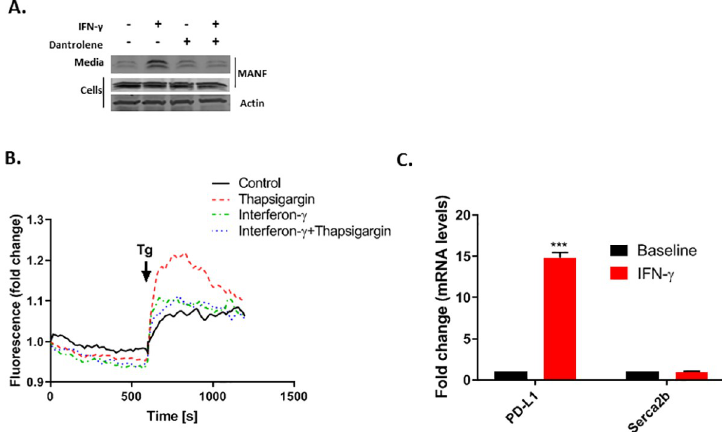
Fig 4. MANF release in response to IFN- γ treatment is mediated by ER Ca 2+ depletion. ( A ) SKMEL28 cells were treated with 100 ng/ml IFN- γ and/or 30 μ M Dantrolene as indicated for 48 hours, followed by immunoblot analysis of the cells and media. Data are representative of three independent experiments. ( B ) SKMEL28 cells were treated for 48 hours with IFN- γ or control as indicated prior to loading with Fluo-3-AM. Thereafter, the medium was switched to 1mM EGTA in HBS and supplemented after 10 min with 1 μ M Tg (indicated by the arrow) for the Thapsigargin and IFN- γ +Thapsigargin treated cells (red or blue dotted lines, respectively), to release any Calcium remaining in the ER, while DMSO was added to the control and IFN- γ (only) treated cells (black and green dotted lines, respectively). Increase in cytosolic calcium was monitored by fluorescence tracing. One representative experiment of four is shown. ( C ) Skmel28 cells were treated with 100 ng/ml IFN- γ for 48 hours, followed by RT-PCR analysis of SERCA2b and PD-L1 (lower panels). RNA expression is relative to baseline. N = 3, data is represented as mean ± SEM. ��� p- value <